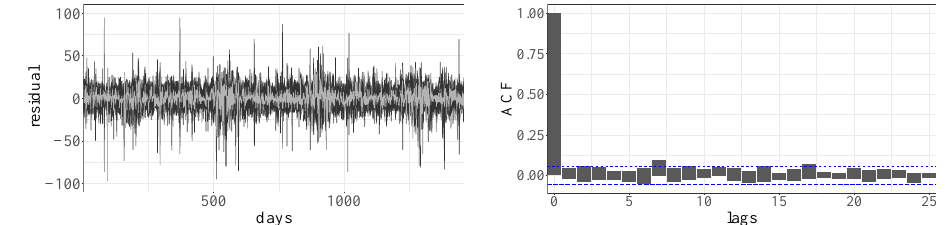
Figure 3. The overlapped residuals’ time plots ( left ) and corresponding autocorrelation ( right ) of hourly time series, for GENESE zone.